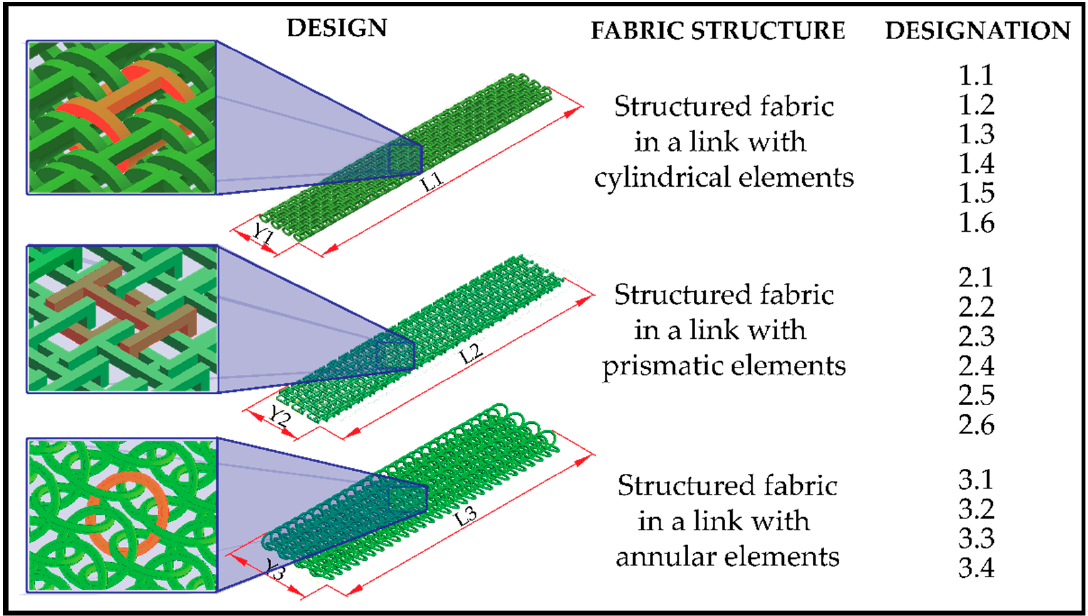
Figure 2. Design and designation of the specimens structured in a linked fabric structure for the research study. Table 1 . Dimensions of unit elements and the specimens.